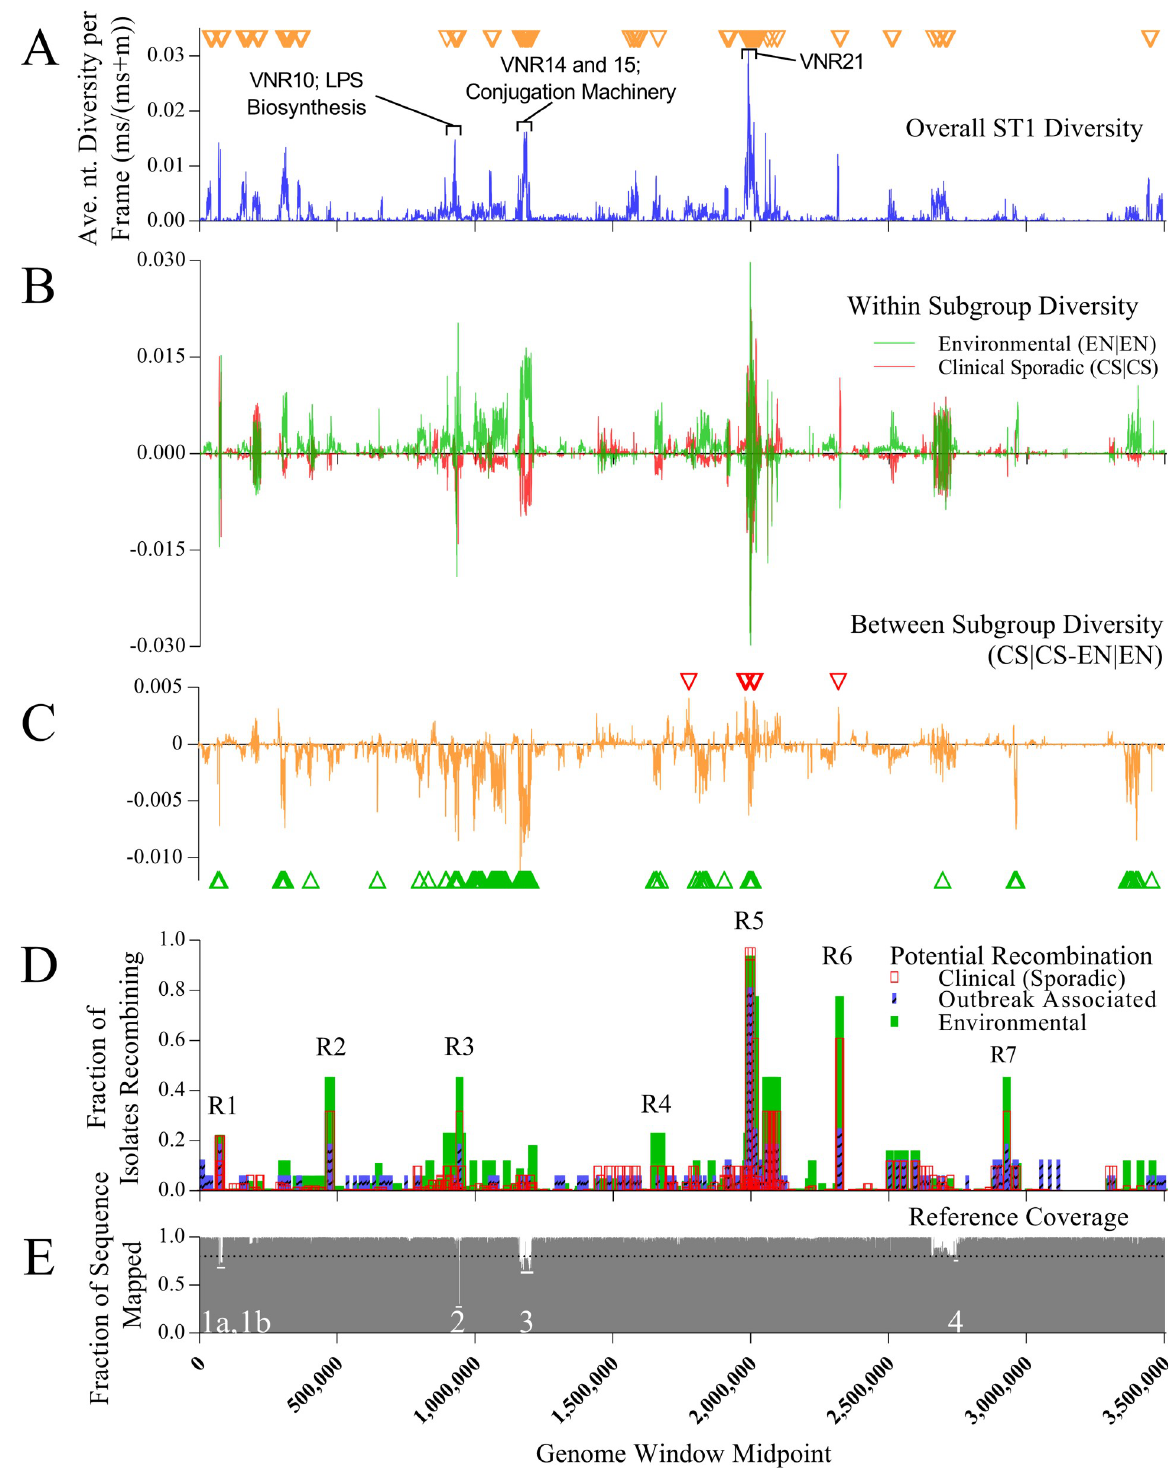
Fig 3. Genetic diversity and potential recombination among ST1 and ST1-like isolate sequences. A) Nucleotide diversity of the combined 501 isolate dataset at 500 bp overlapping windows relative to L . pneumophila str. Paris. Gold inverted triangles indicate windows that meet or exceed the 3% diversity threshold. B) Within group nucleotide diversity of the EN and CS subgroups, where the subgroup with the highest diversity at any single window is displayed in the positive Y axis while the subgroup with lower diversity is displayed in the negative Y axis. C) Nucleotide